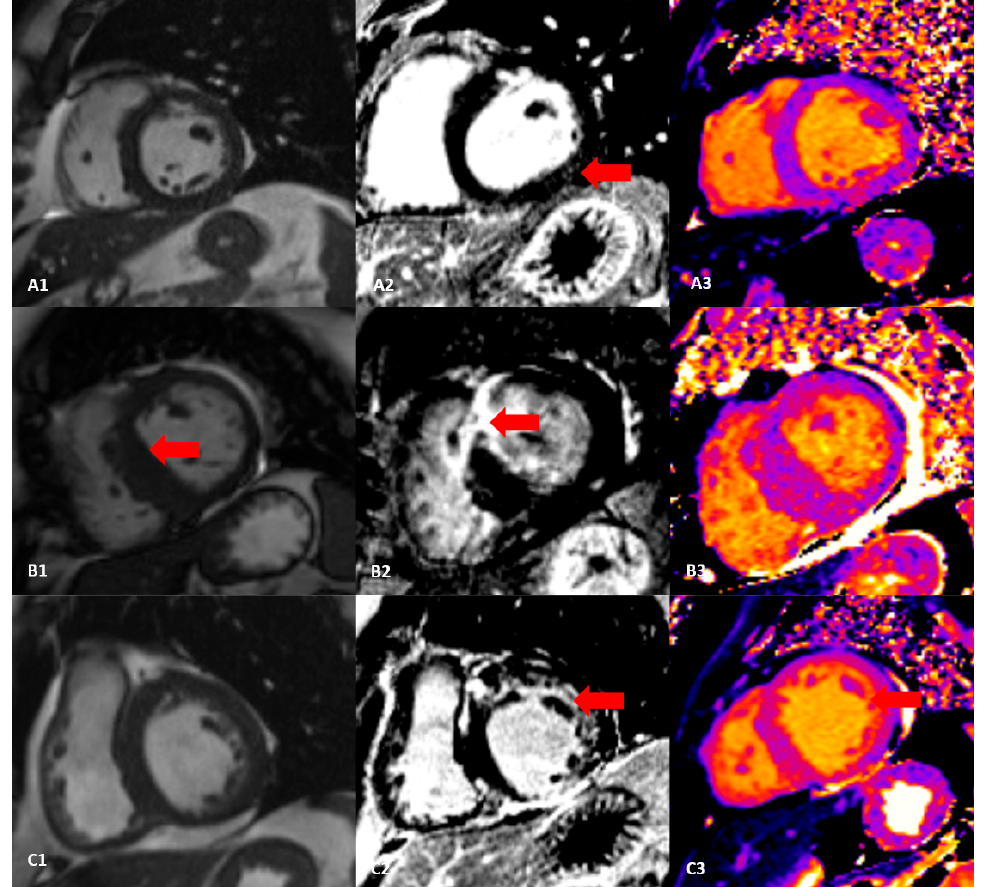
Figure 4. Cine sequences, LGE patterns, and native T1 mapping in patients with hypertensive heart disease, hypertrophic cardiomyopathy, and amyloidosis ( A1 ): short ‐ axis cine sequences with hypertrophic septum in a patient with hypertensive heart disease (HHD); ( A2 ): subtle focal LGE phenomenon in a patient with HHD (marked by red arrow); ( A3 ): T1 mapping showing diffuse borderline values of native T1 time in a patient with HHD; ( B1 ): Hypertrophic cardiomyopathy with predominant septal hypertrophy (marked by red arrow); ( B2 ): Septal LGE phenomenon in a patient with hypertrophic cardiomyopathy (marked by red arrow); ( B3 ): T1 mapping in a patient with HCM revealing prolonged native T1 time (especially in the septum, which is important discriminator between HHD and HCM); ( C1 ): cine sequences in short ‐ axis revealing left ventricular hypertrophy in a patient with amyloidosis; ( C2 ): diffuse subendocardial LGE phenomenon in a patient with amyloidosis (marked by red arrow); ( C3 ): T1 mapping showing prolonged native T1 time in the subendocardium